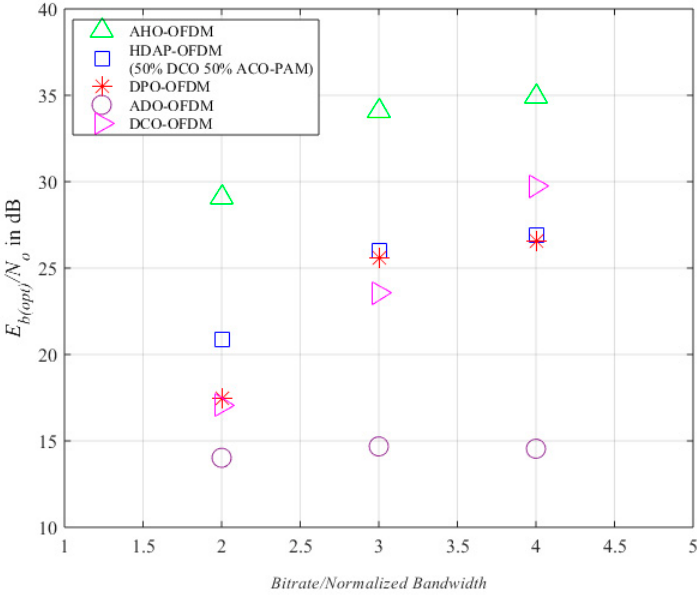
Figure 7. Optical energy per bit to noise power spectral density ( E b ( opt ) / N 0 ) versus bit rate/normalized bandwidth ( R ) for different orthogonal frequency division multiplexing (OFDM) forms considering a bit error rate (BER) of 10 − 3 .